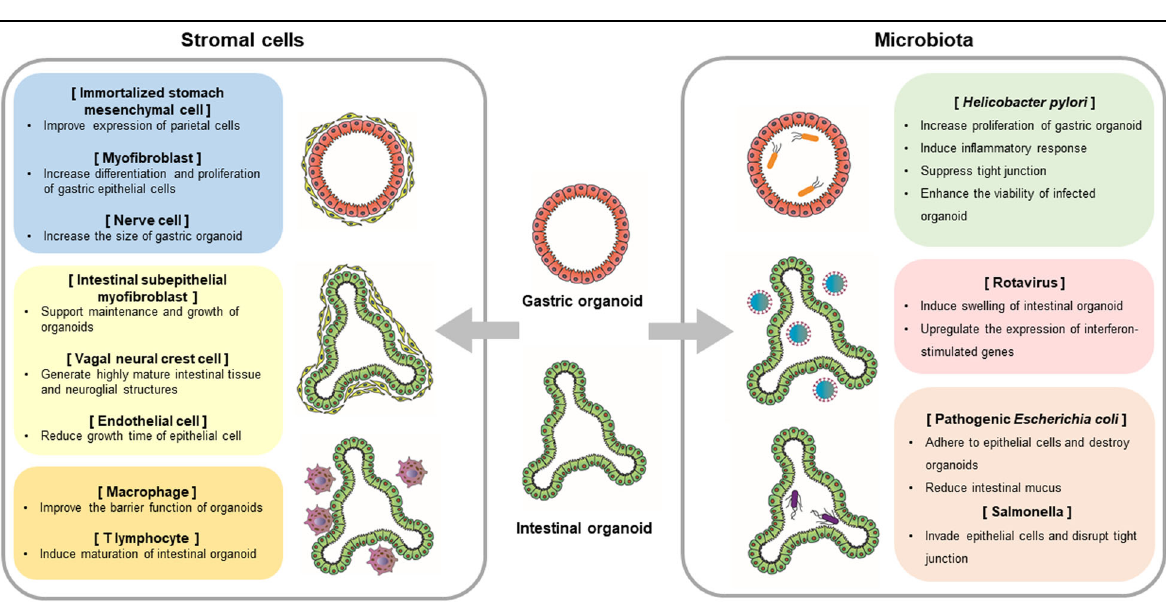
Fig. 2 Coculture models of GI organoids with stromal cells and microbiota. The biological effects of various stromal cells and microbiota on GI organoids in coculture models are described.